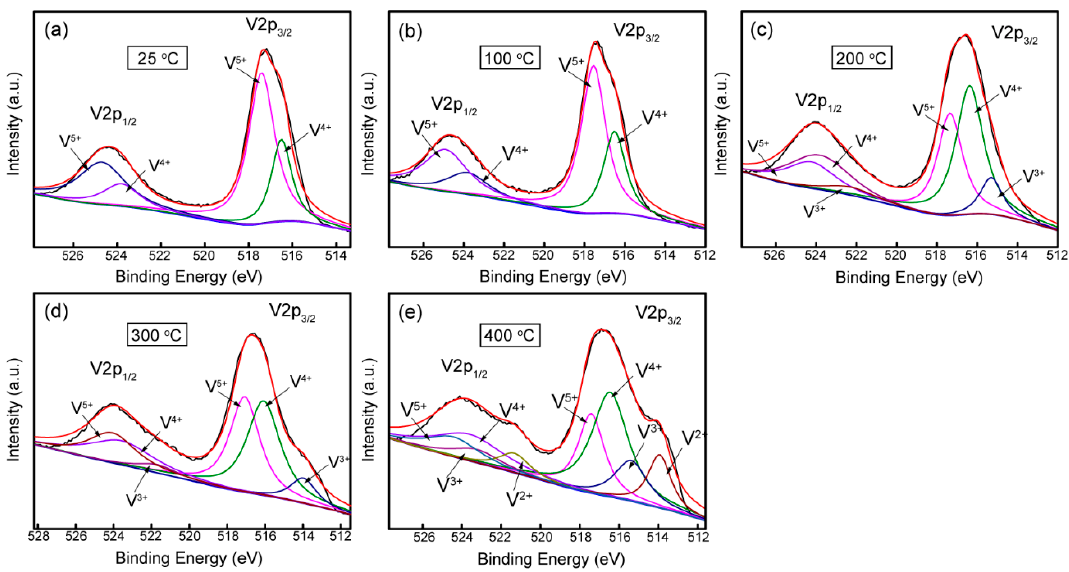
Figure 11. XPS spectra of V films deposited on Si (100) at D t-s = 60 mm, T s = ( a ) 25 °C, ( b ) 100 °C, ( c ) 200 °C, ( d ) 300 °C, and ( e ) 400 °C.